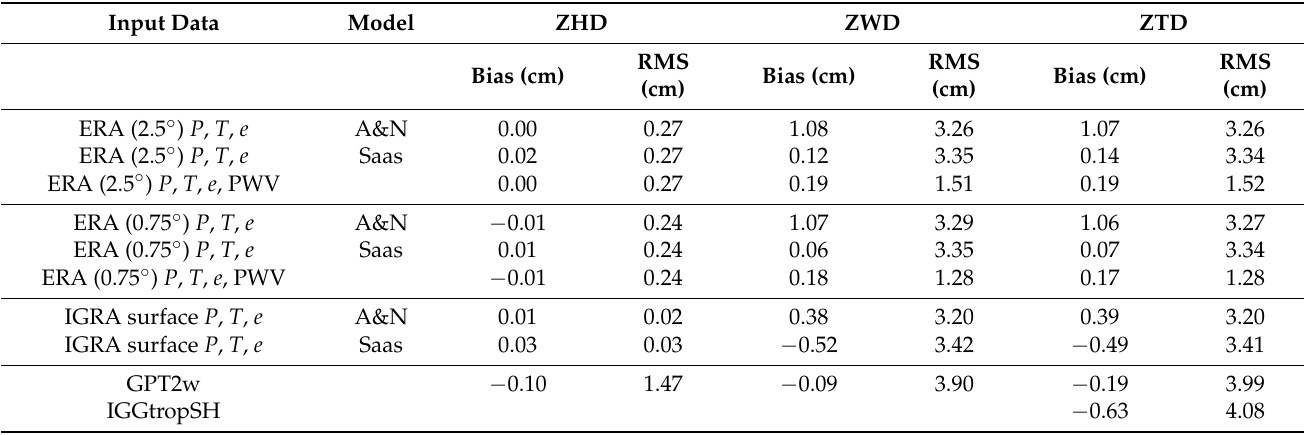
Table 4. Statistics of global mean accuracies of ZHDs, ZWDs, and ZTDs calculated from ERA-Interim surface analysis data, with the reference values from IGRA data over 530 stations during 2015. Statistics on tropospheric delays obtained from actual surface meteorological parameters and two empirical tropospheric models GTP2w and IGGtropSH, respectively, are also